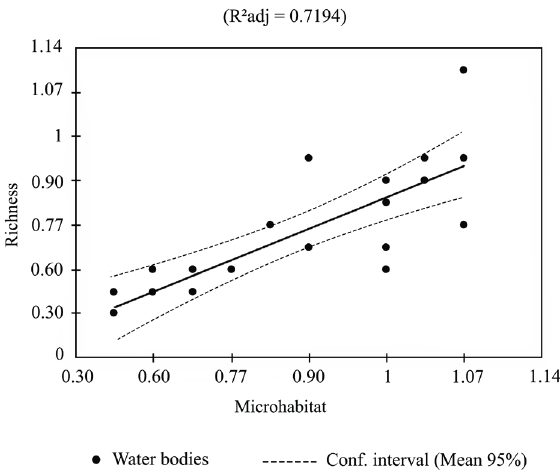
Figure 2 - linear regression between microhabitats and richness of anuran species in the 23 water bodies located in the agricultural landscape, forest landscape, forest edge landscape, and urban landscape.